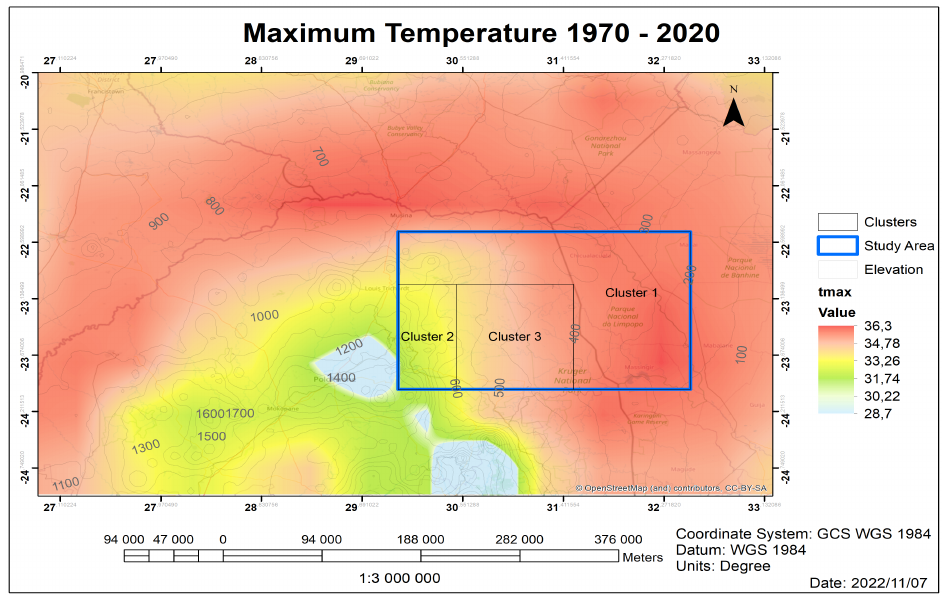
Figure A2. Map for the annual maximum temperature in the Lowveld region of Limpopo with three clusters. Source: Authors’